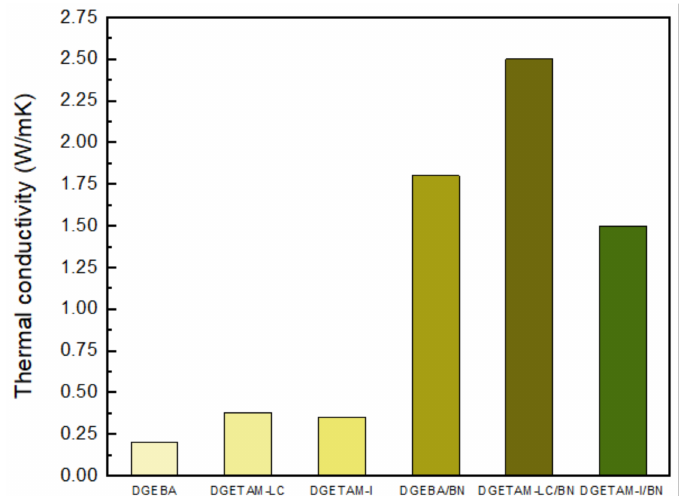
Figure 13. Thermal conductivities of epoxy/m-PDA and epoxy/m-PDA/BN filler 35